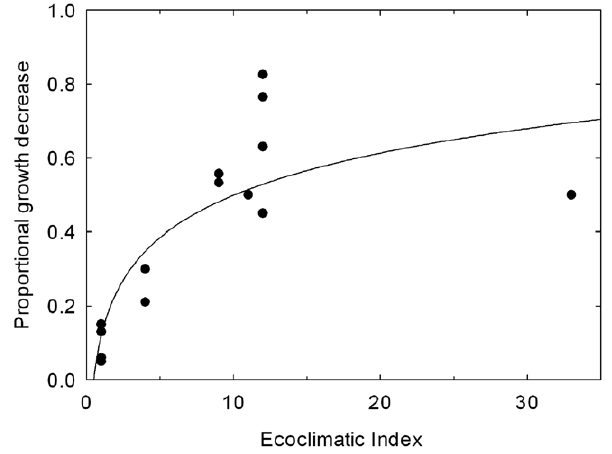
Figure 4. Growth impacts from Thaumetopoeapityocampa as a function of climate suitability modelled using CLIMEX. The location of sites with reported growth impacts used to develop the relationship are indicated in Figure 2.